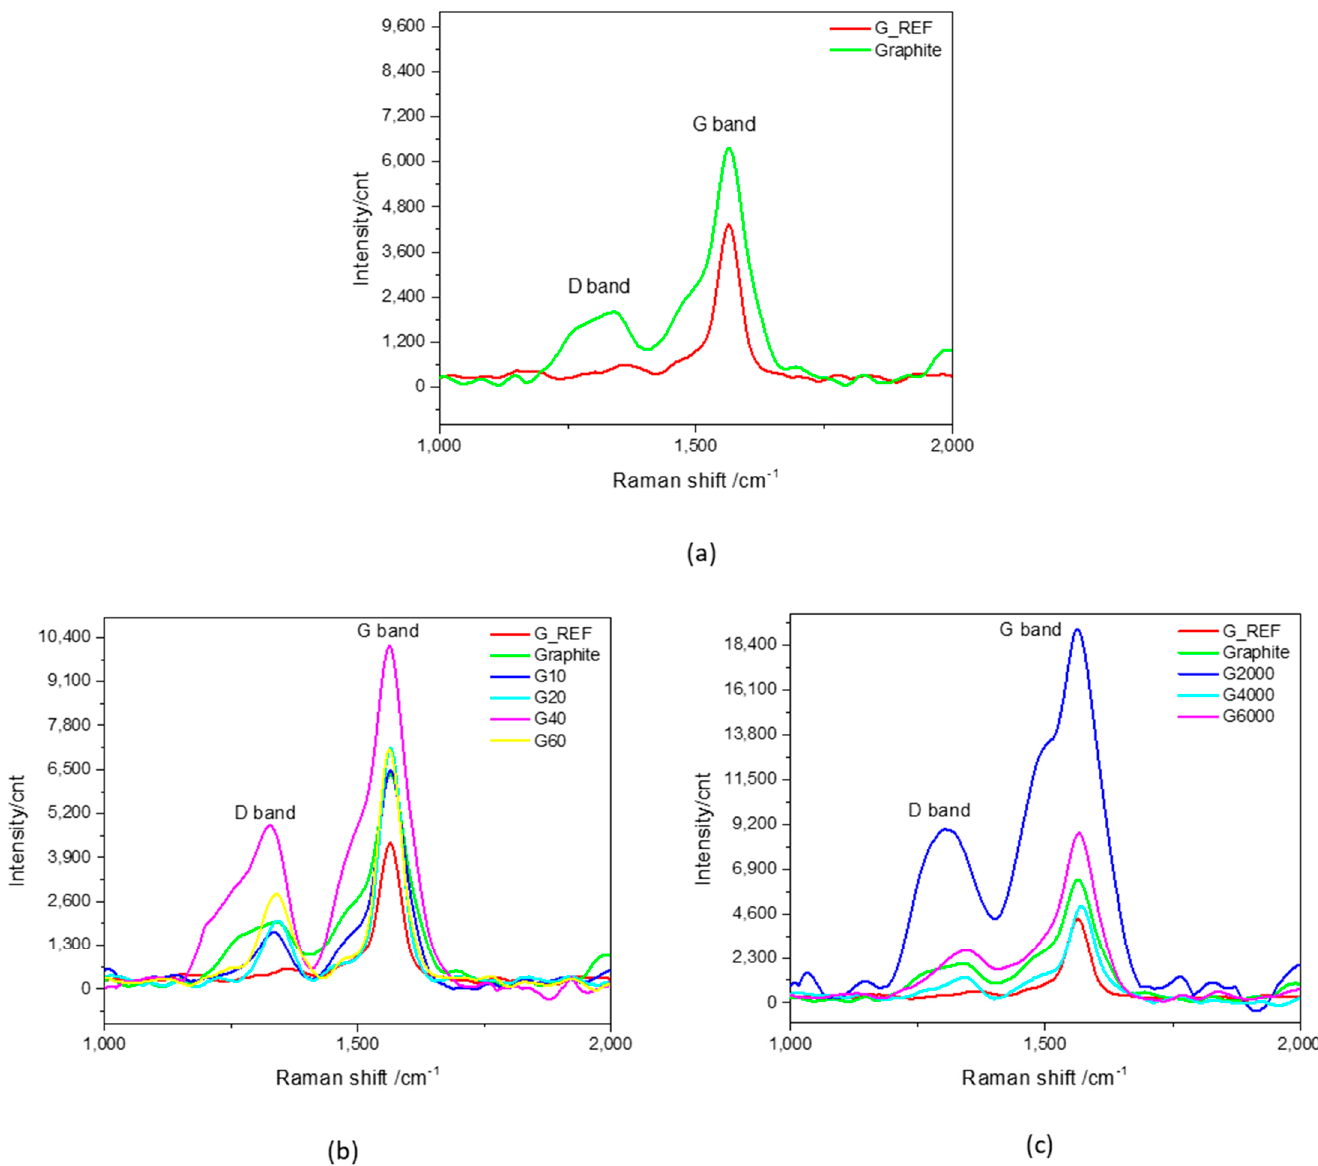
Figure 5. Raman spectra (1000–2000 cm − 1 ) of ( a ) G_REF and commercial graphite, ( b ) MM400 ball − milled graphitic samples, and ( c ) Ultra − Turrax ball − milled graphitic samples.